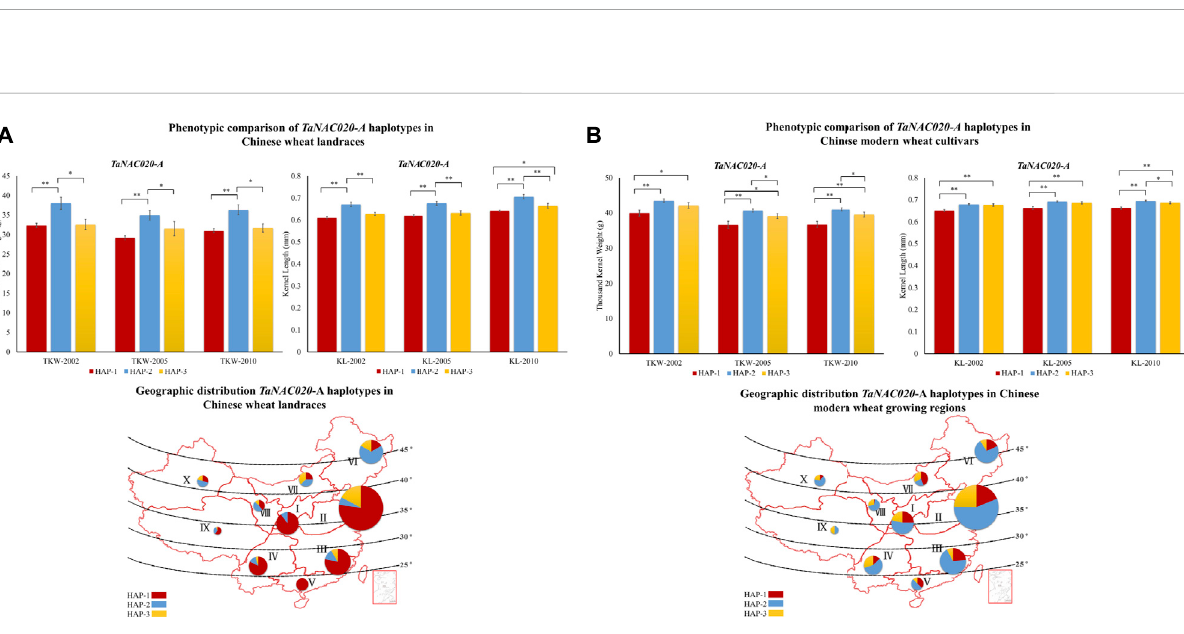
FIGURE 4 Phenotypic comparison of TaNAC020-A haplotypes and their distribution in 10 Chinese major wheat production zones. (A) Phenotypic comparison and geographic distribution of haplotypes in Chinese wheat landraces. (B) Phenotypic comparison and geographic distribution of haplotypes in Chinese modern wheat cultivars. * p < 0.05, ** p < 0.01, error bar denotes SE. The size of the pie chart is directly proportional to the number of accessions from the agroecological